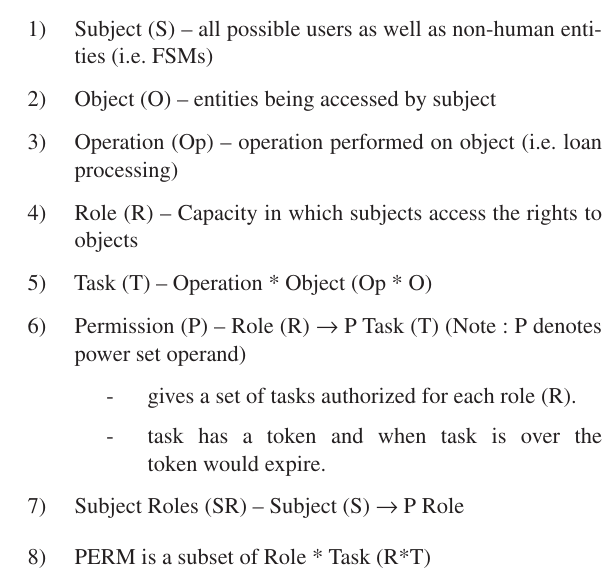
Figure 5 highlights the proposed trust based autonomous banking platform where trust delegation is included. A total of